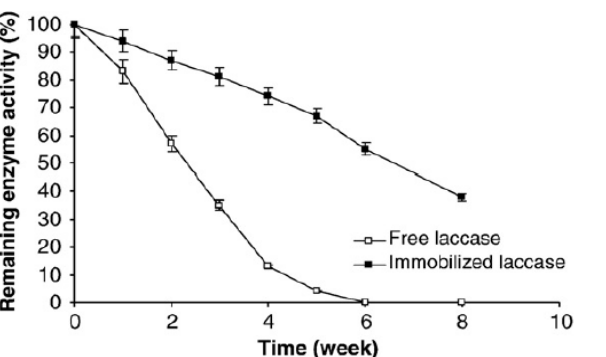
Figure 2. Remaining activity of laccase when: immobilized on a polycationic fibrous polymer film (black squares), in solution (hollow squares) [40]. Storage temperature 4